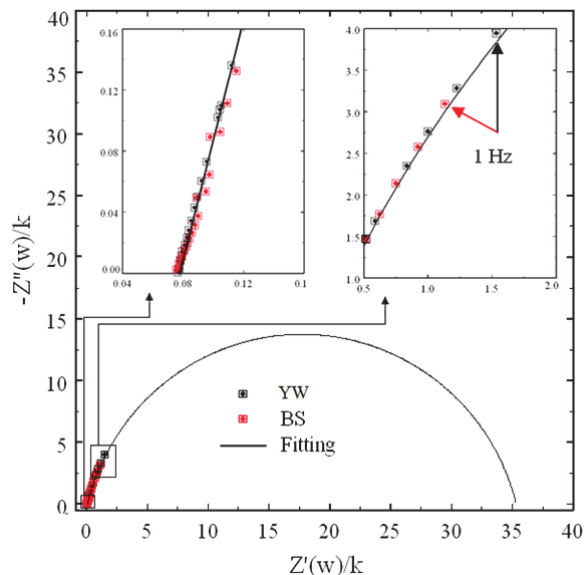
Fig.3: Argand diagram of the EEI for gold electrodes polished at 1 μ m. Z ′ and Z ″ are the real and imaginary parts of the impedance. AC overpotential = 10 mV, DC overpotential = 0 V. Error bars for the two axes are symmetric and are represented by a box.